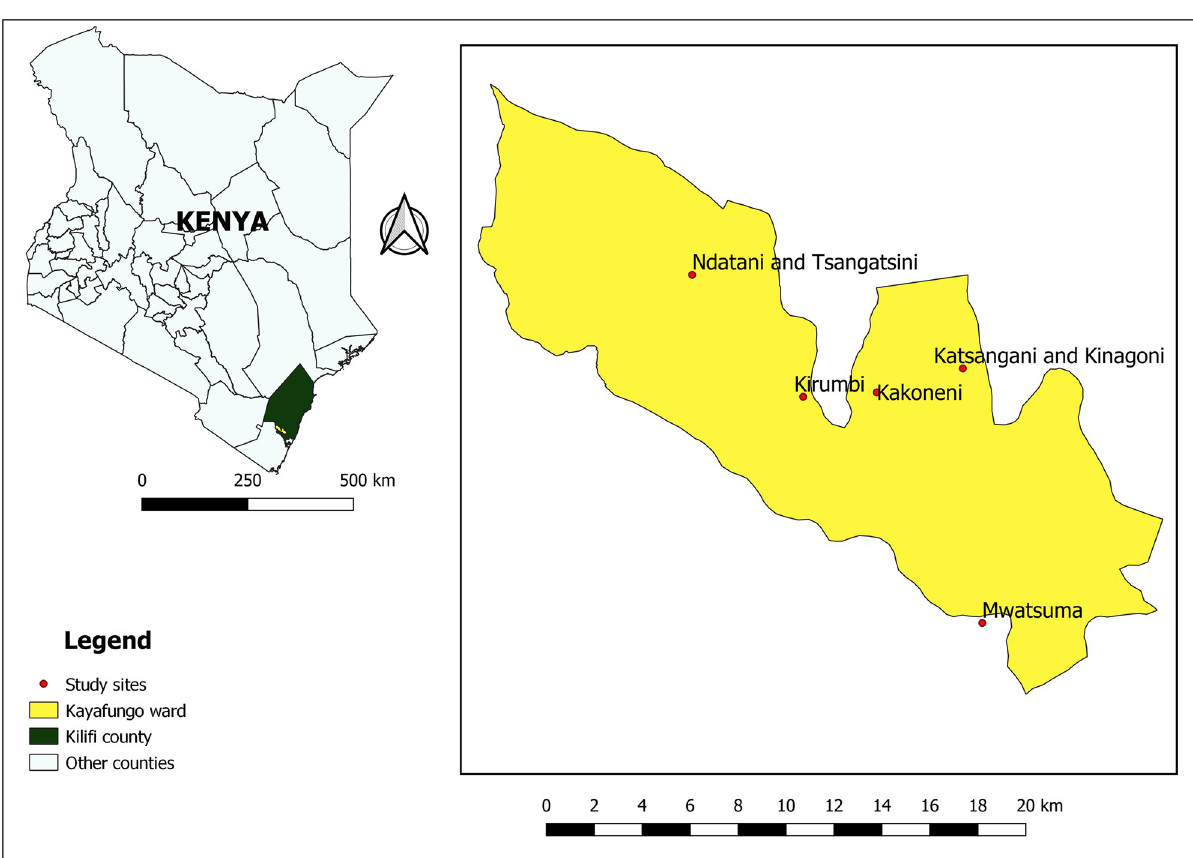
Fig 1. Map of Kayafungo ward in Kilifi county in coastal Kenya showing the trial sites. This map is republished with data under CC BY licenses from the following sources: https://africaopendata.org/dataset/kenya-counties-shapefile from openAfrica, 2015 [36]; and https://gadm.org/download_ country_v3.html from GADM, 2018